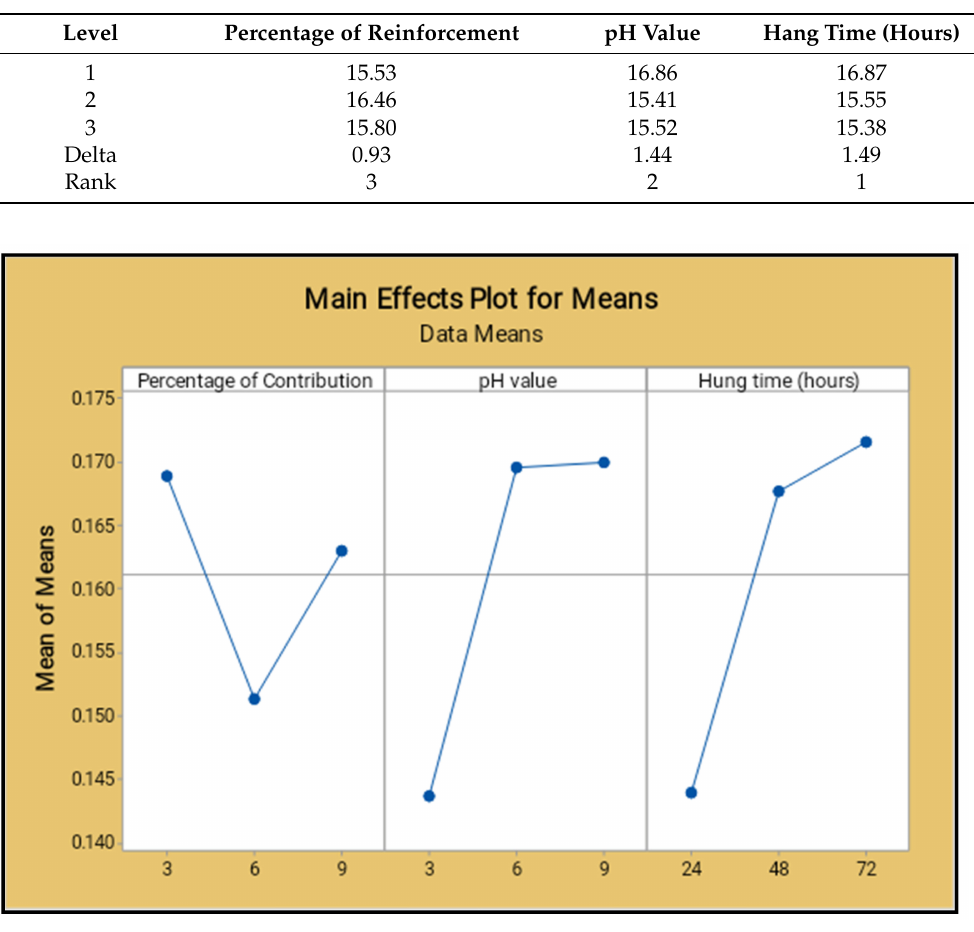
Figure 22. Main effect plot for means (salt spray